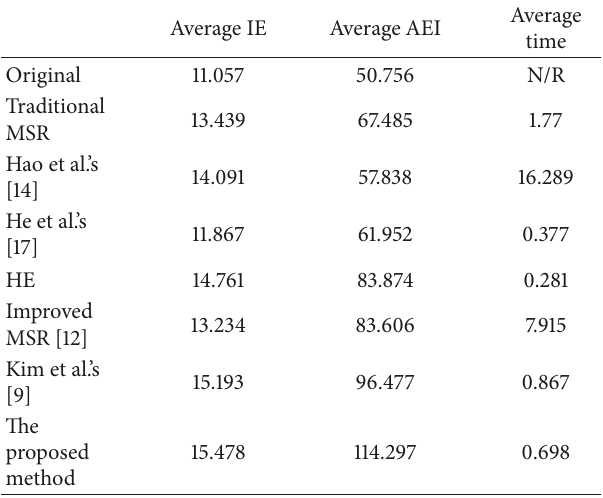
Table 1: The average IE, AEI, and operating time (sec) on twenty